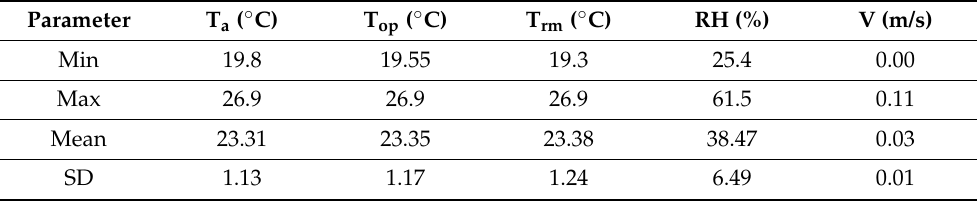
Table 5. Summary of the environmental